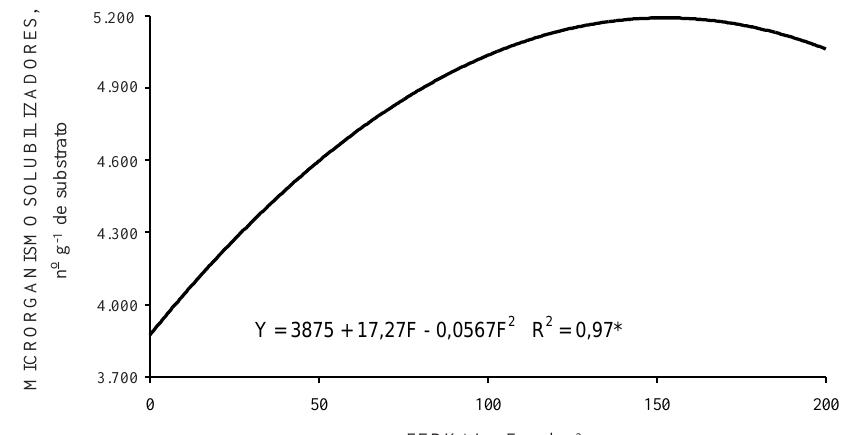
Figura 3. Número de microrganismos solubilizadores de fosfato no substrato, considerando as doses de Ferkal. Significativo a 5%